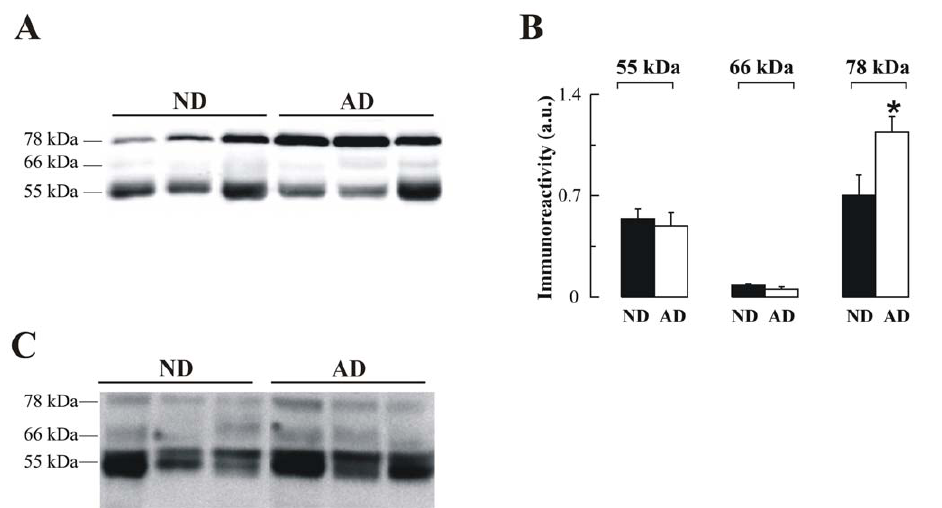
Figure 5. Altered AChE immunoreactivity in plasma of non-demented controls (ND) and Alzheimer’s disease (AD) patients. ( A ) Representative blot of plasma-AChE from AD and ND using the antibody N-19, and ( B ) densitometric quantification of the AChE-immunoreactive bands, expressed in arbitrary units (a u.), from 15 ND ( & ; n=15) and 14 AD ( % ; n=14) subjects. Proteins abundant in plasma were depleted by immunoaffinity-based protein subtraction chromatography with IgY microbeads (Seppro TM ) and equivalent amounts of protein were loaded in each lane. Columns represent means 6 SEM * p =0.02 significantly different from NDs as assessed by Student’s t test. ( C ) Representative blot of plasma AChE detected with the anti-AChE antibody to the C-terminal, ab31276.